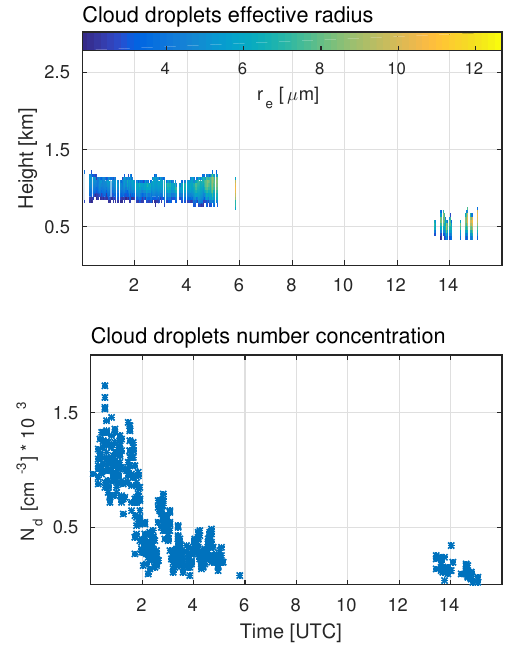
Figure 2. The time–height cross section of the cloud droplet effec- tive radius ( r e ) calculated from WACR and MWR measurements (Eq. 10) and the cloud droplet number concentration ( N d ) calcu- lated from Eq. (11) from 3 November 2009. Data are only retrieved in the time steps when the data selection criteria are met.